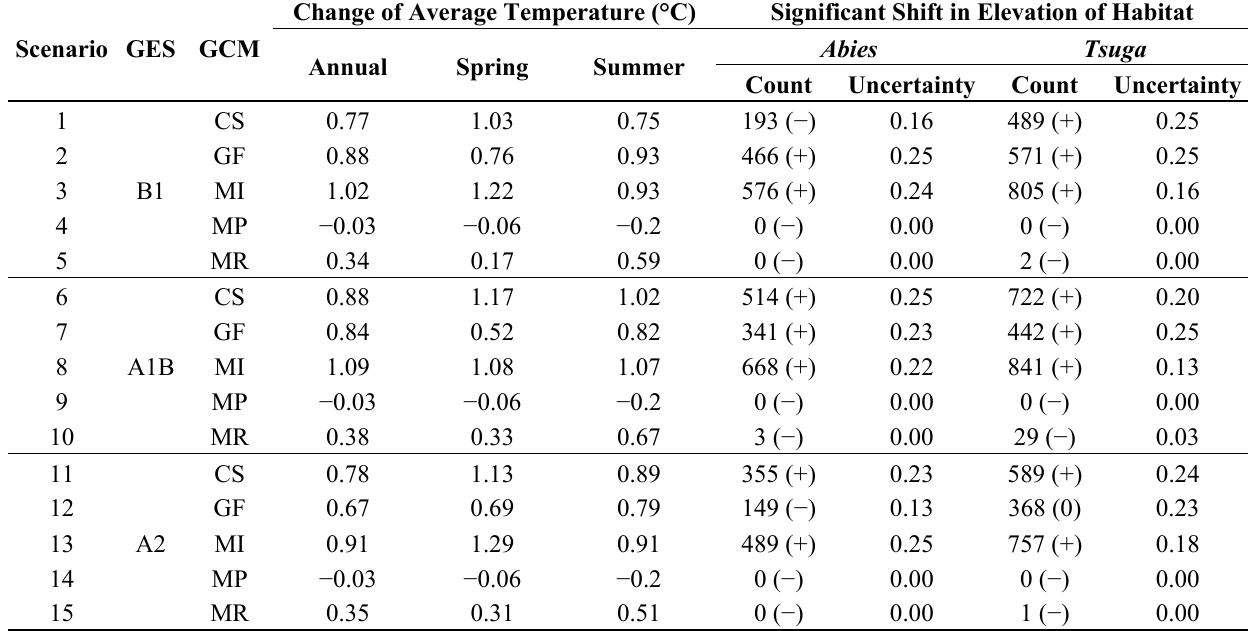
Table 1. The difference in temperature under each climate change scenario (for 2020–2039) in comparison to the baseline scenario, and the number of statistically significant differences in the optimal elevation of focal species habitat in 1000 different sets of outputs, which are contained in the 95% bootstrap confidence